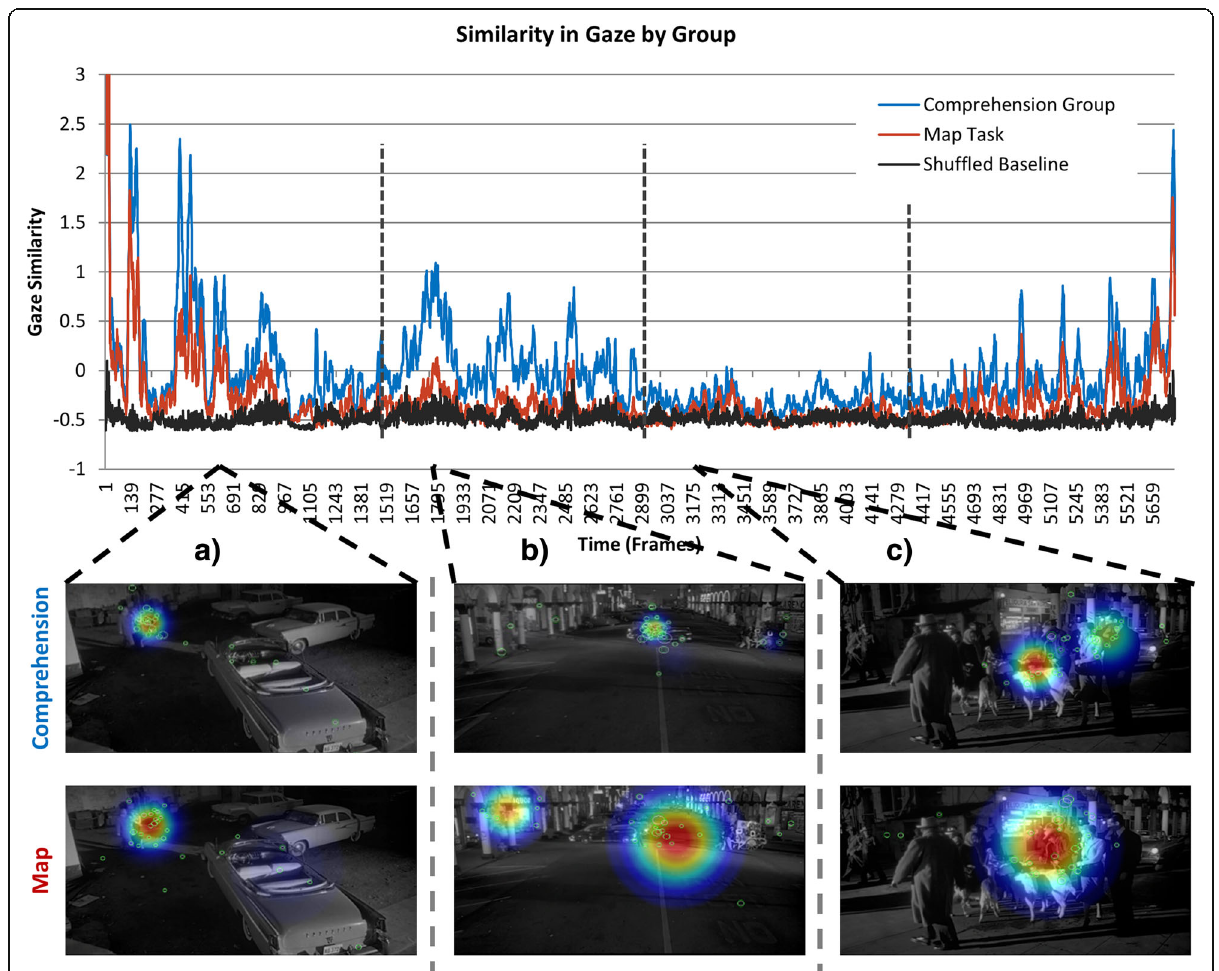
Fig. 6 Top : Similarity of gaze by context condition across the full clip. Gaze similarity is expressed as a z-score probability relative to the context condition and inference made (Comprehension group [ blue ], Map task [ red ], and shuffled baseline [ black ]). Large values indicate greater attentional synchrony. Vertical dashed grey lines illustrate the quarters used in the repeated measures analysis. Bottom : The stills exemplify gaze patterns during high gaze similarity (GS) for both groups ( a ), high GS for Comprehension, low for Map Task ( b ), and low GS for both ( c